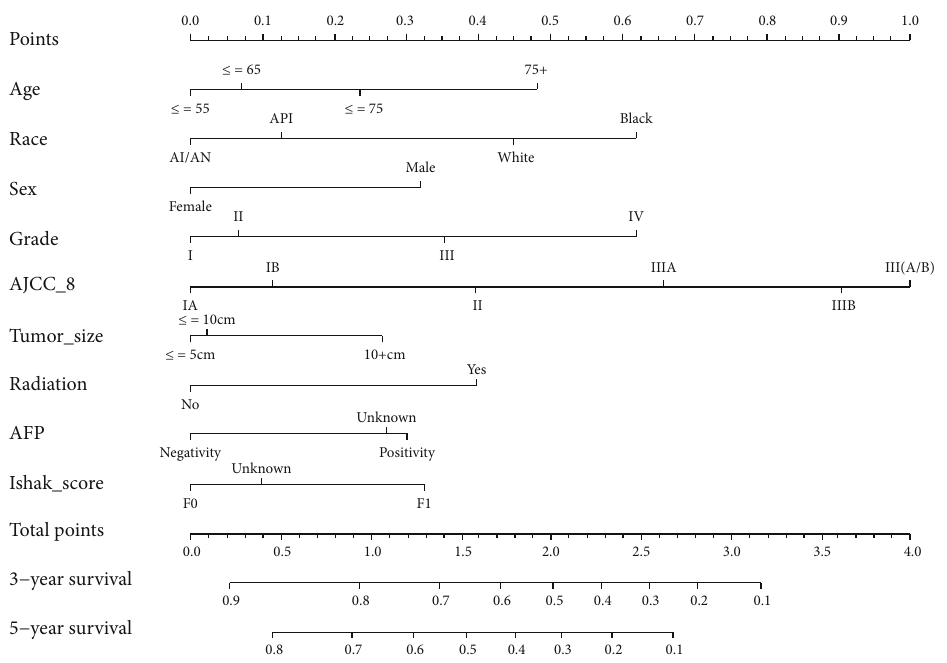
Figure 4: Nomogram predicting 3-/5-year survival probability of HCC patients after hepatectomy. Total points are gained by adding up all the points of each variable, and the vertical projections on lower axis present the 3-/5-year survival probability of HCC patients after hepatectomy. AFP: the highest serum α -fetoprotein level prior to